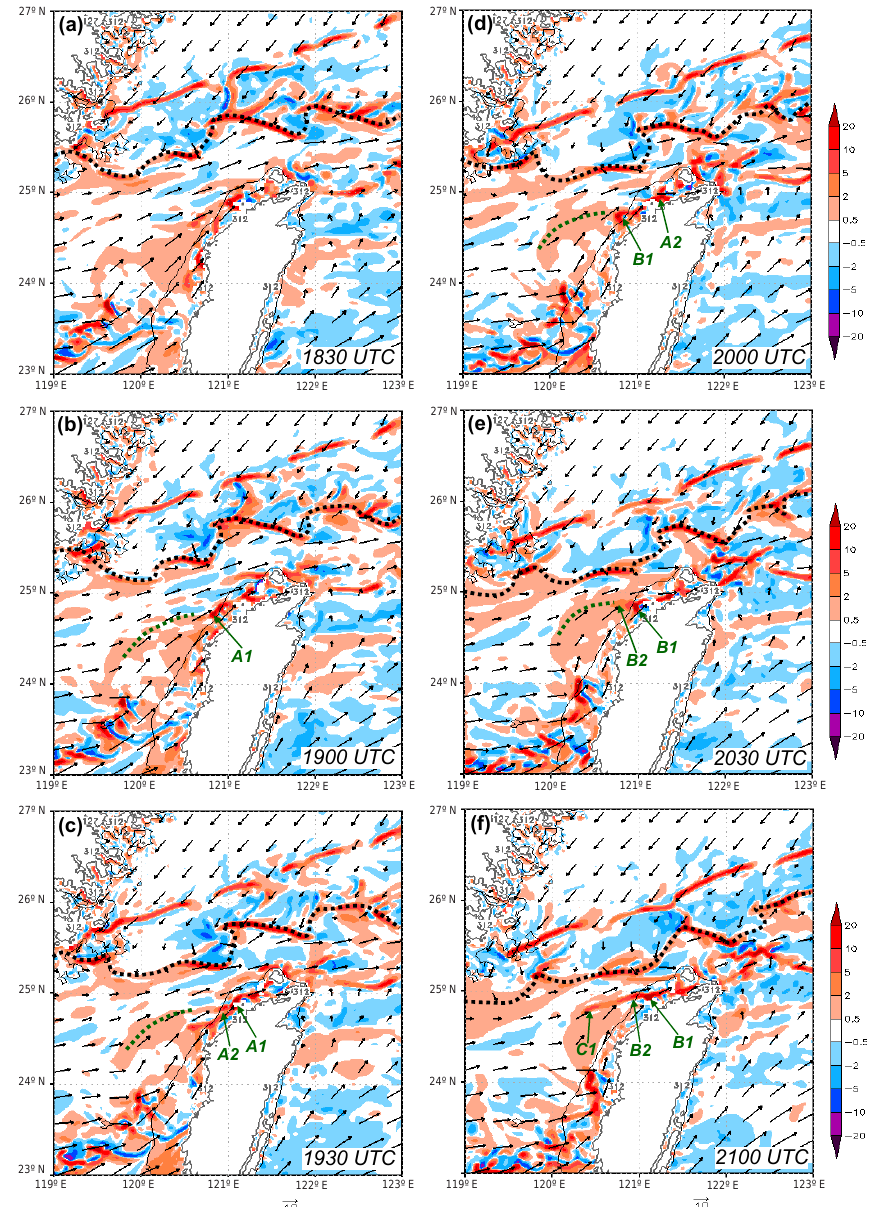
Figure 9. CReSS simulation of horizontal winds (ms − 1 , vectors, reference length at bottom) and convergence/divergence (10 − 4 s − 1 , shad- ing, scale to the right, positive for convergence) at 312m height (contoured in thick gray) every 30min from (a) 18:30UTC to (f) 21:00UTC on 11 June 2012. The frontal positions (black dotted lines) and convergence axis (green dotted lines) and convective cells of interests are